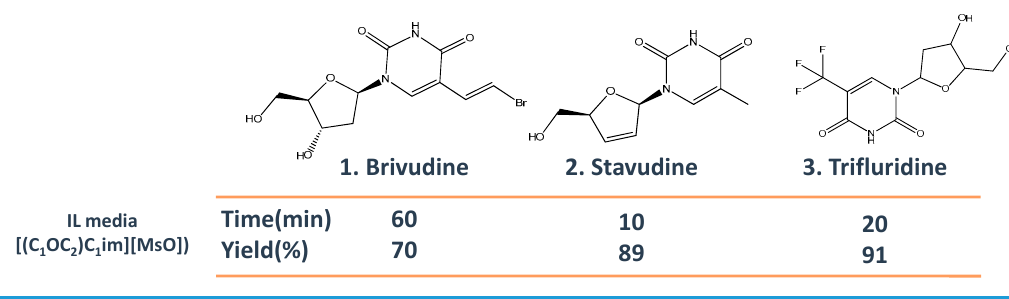
Figure 5. Synthesis of nucleoside-based antiviral drugs in IL media proposed in [56].